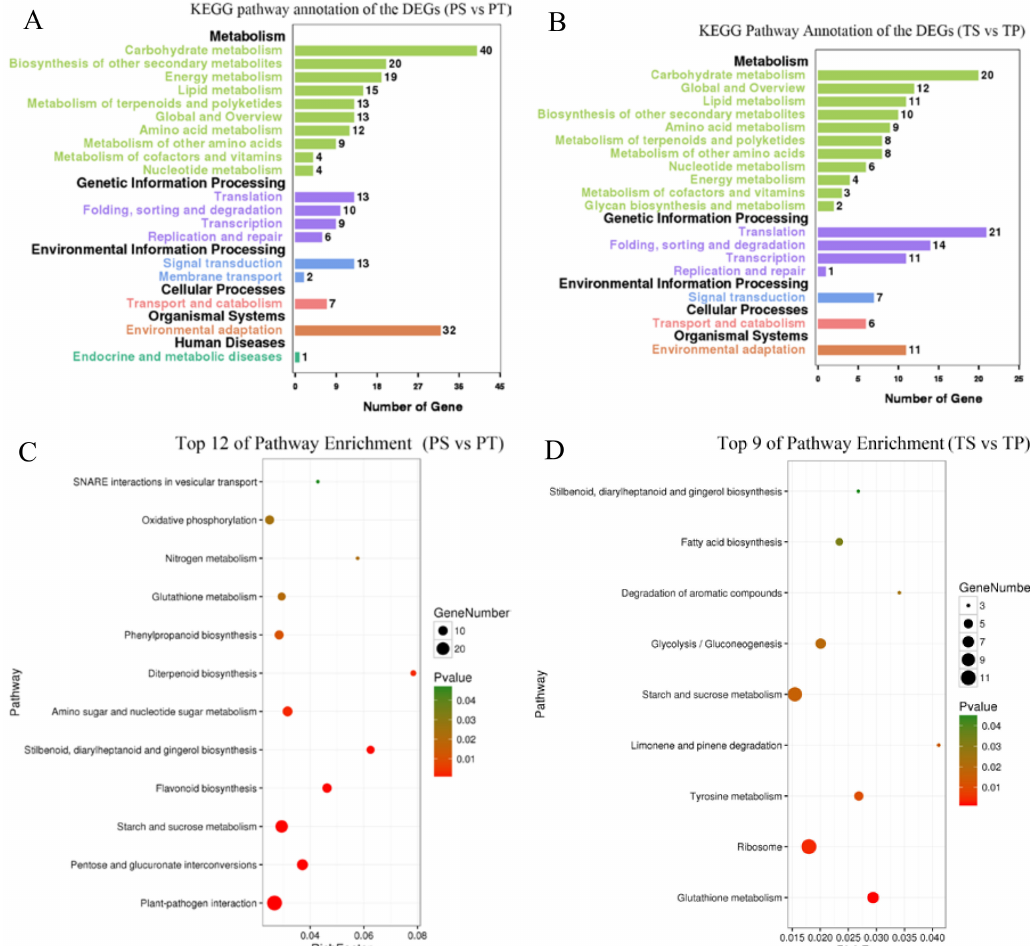
Figure 4. KEGG enrichment analyses of DEGs from PS vs. PT and TS vs. TP comparisons. ( A ) Number of DEGs from PS vs. PT comparison in various KEGG pathways; ( B ) Number of DEGs from TS vs. TP comparson in various KEGG pathways; ( C ) Top 12 most significantly enriched pathways in PS vs. PT comparison ( p < 0.05); ( D ) Top nine most significantly enriched pathways in TS vs. TP comparison ( p < 0.05). The number of genes in each category is proportional to the size of each dot, and the color of each dot represents the p